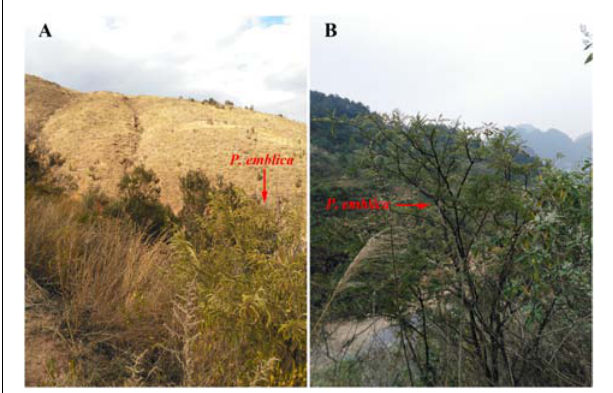
FIGURE 2 | The habitats of P. emblica distributed in dry-hot valley of Yunnan (A) and humid areas of Guangxi (B) .